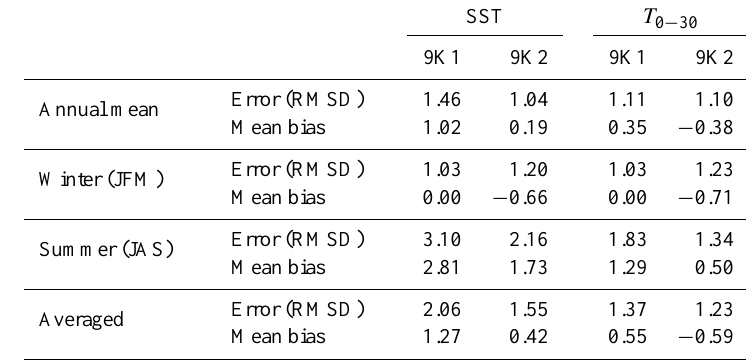
Table 3. Mean error and mean biases